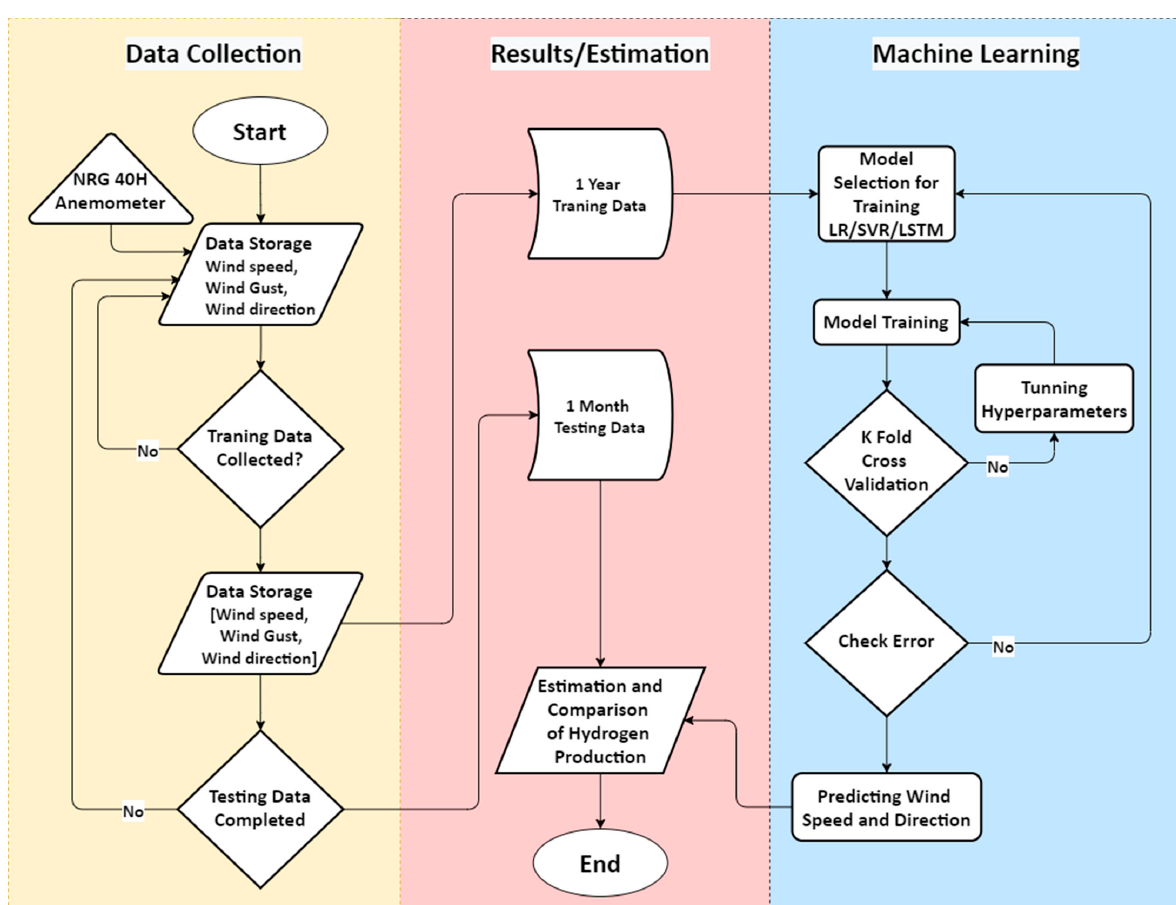
Figure 3. Workflow diagram for forecasting hydrogen production.